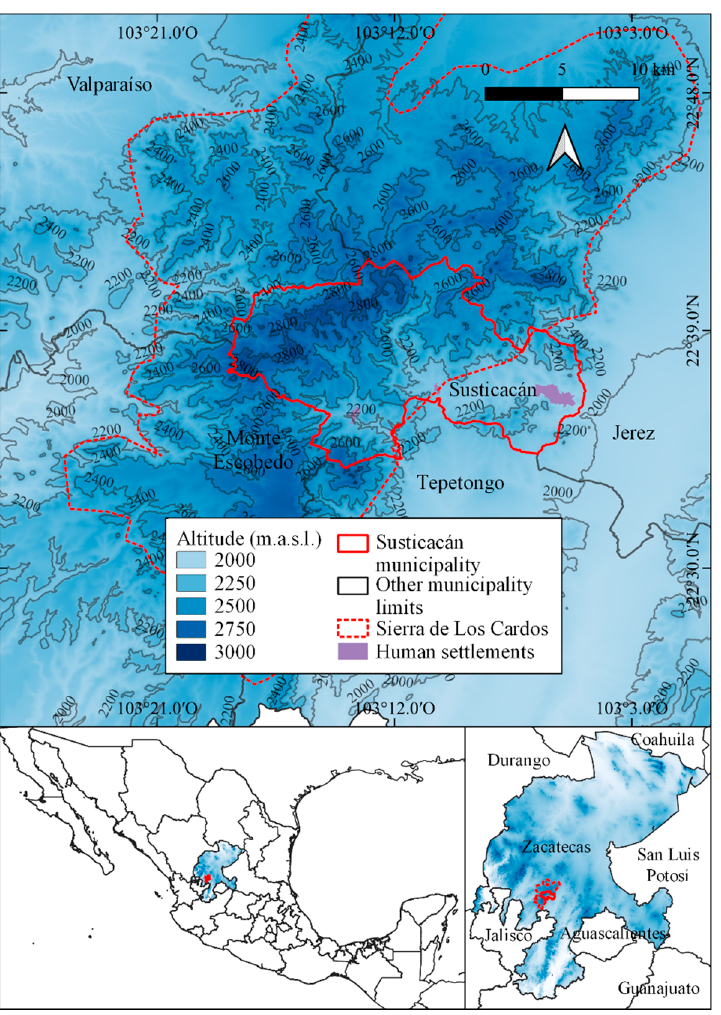
Figure 1. Geographic location of the Sierra de los Cardos in the municipality of Susticacán, Zacatecas, Mexico.